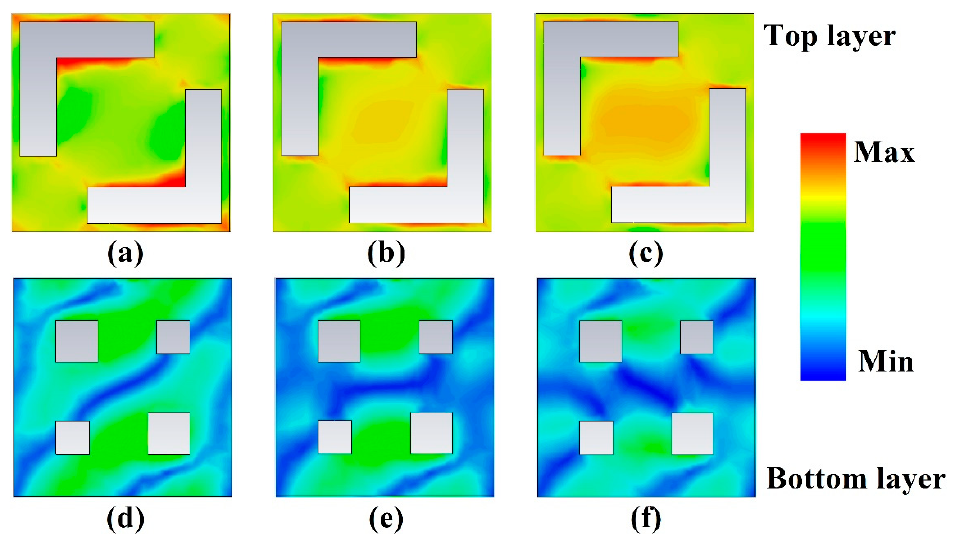
Figure 5. The magnitude distribution of electric field on top and bottom films at different frequencies. ( a - c ) The magnitude distribution of electric field at 6GHz, 12 GHz and 18 GHz on top layer. ( d - f ) The magnitude distribution of electric field at 6GHz, 12 GHz and 18 GHz on bottom layer.